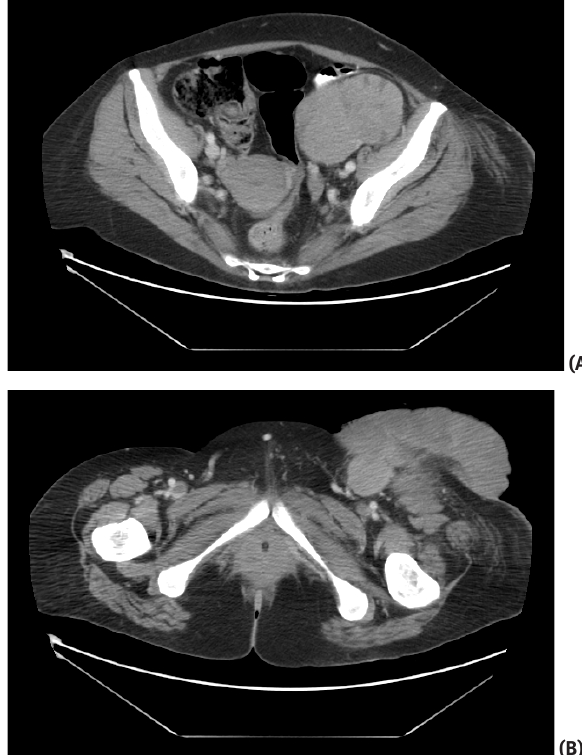
Figure 2: Computed tomography scans at the time of diagnosis. A metastasis to the left ovary (A), ulcerated solid tumor in the left groin (B), and partial thrombosis of the right femoral vein in the coronal plane are